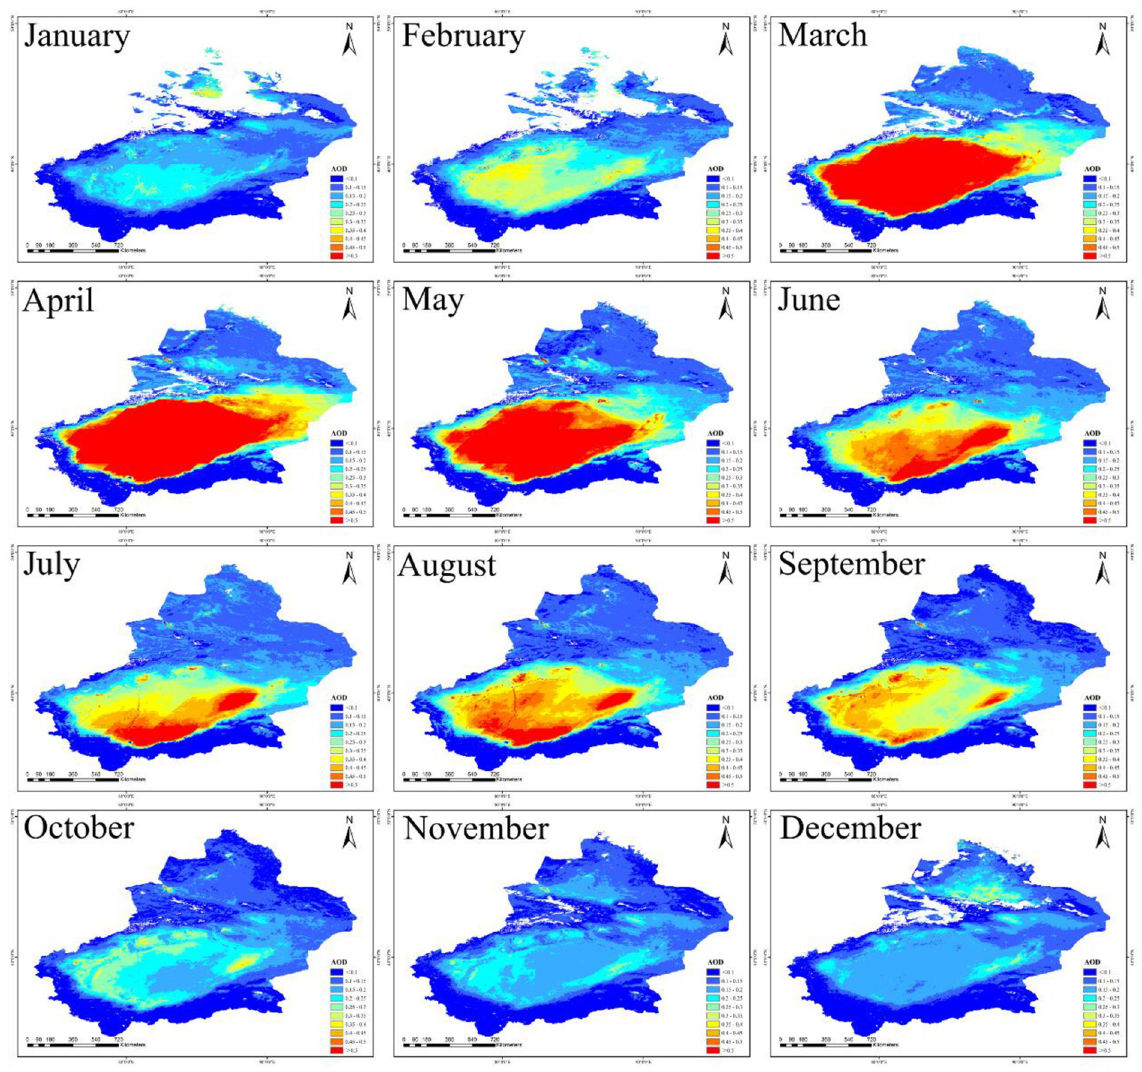
Fig 4. Spatio distribution of average AOD in different months (The red is the highest value and dark blue represents the lowest value. Map is created using ArcGIS version 10.3. Xinjiang Uygur Autonomous Region is downloaded from The Gateway to Astronaut Photography of Earth website (https://eol.jsc.nasa.gov/SearchPhotos/). Map credit: Jinglong Li).